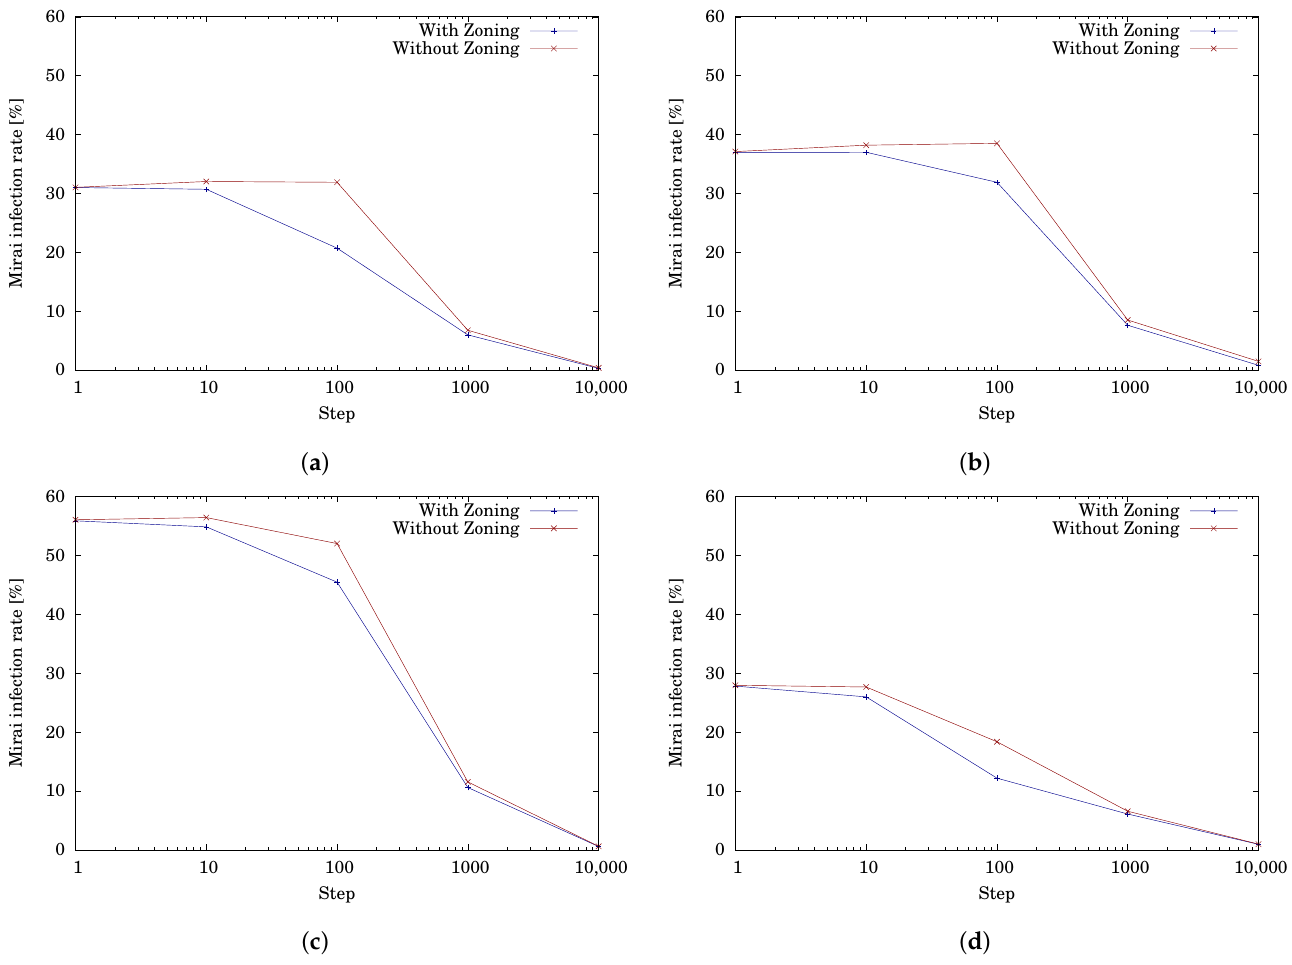
Figure 9. Comparison of the Launchers with and without zoning. ( a ) Distribution 1, ( b ) Distribution 2, ( c ) Distribution 3, and ( d ) Distribution 4. Table 4. Positioning of this study among the related